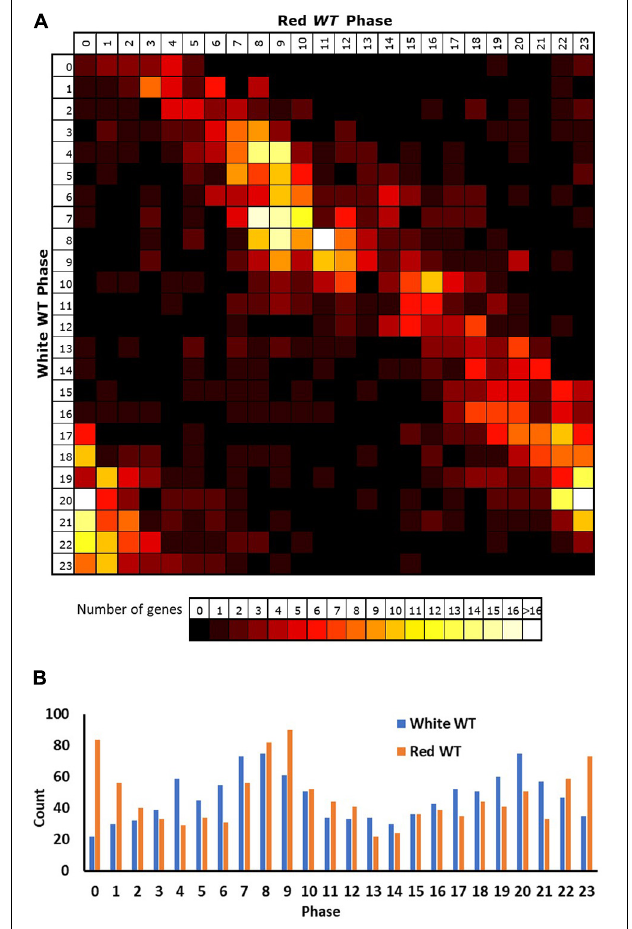
FIGURE 2 | Rhythmic genes show a slightly delayed phase in red light. Phases of genes identified as rhythmic in wild type (WT) seedlings in both white and red light based on microarray data. (A) Genes were grouped by their calculated phases in each light condition and numbers of genes for each phase combination were represented as a heatmap. (B) Total number of genes displaying each phase in the two